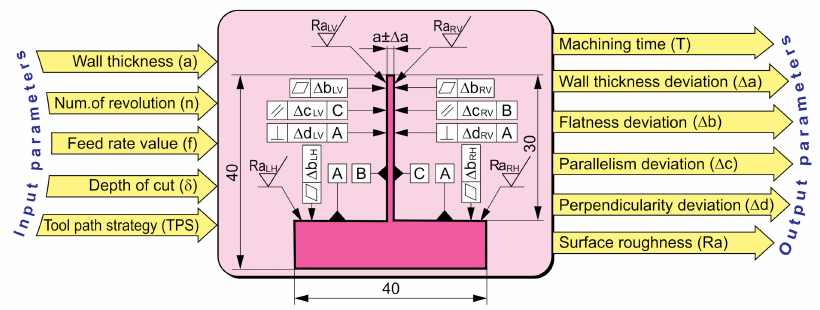
Figure 2. The optimization tasks (unit: